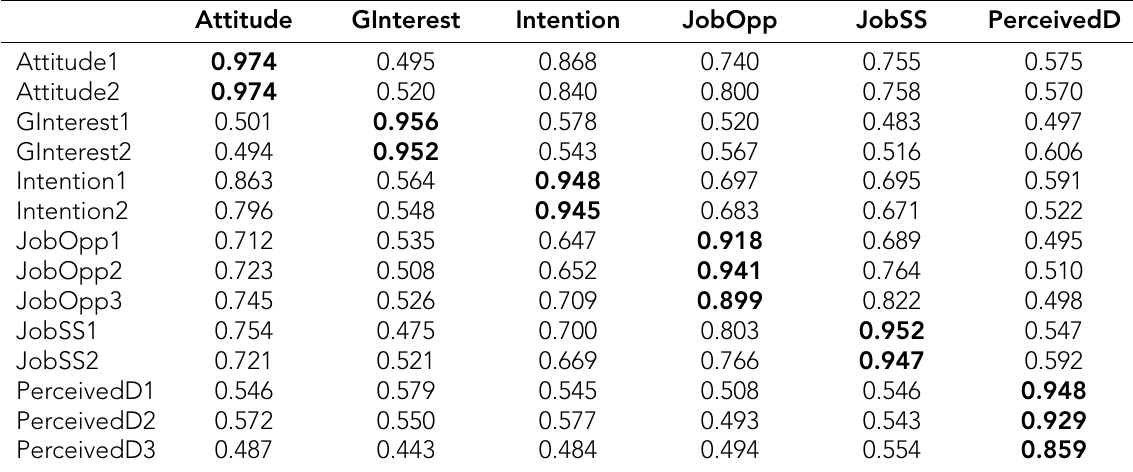
Table 5. Outer loadings and cross-loadings of latent variables (Source: Authors, 2022)